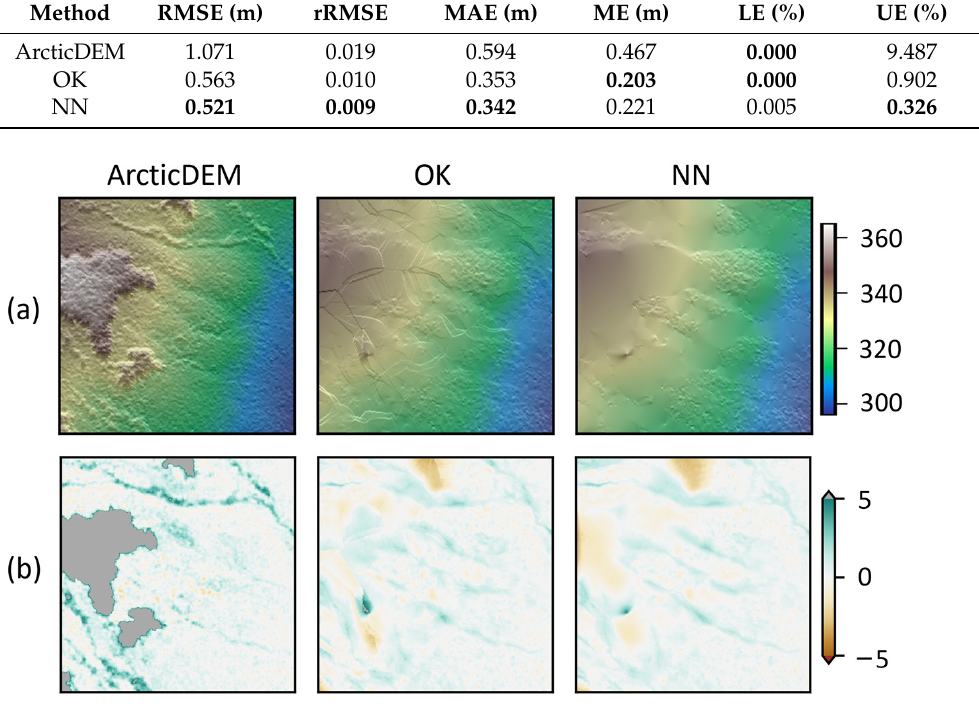
Table 5. Model evaluation metrics at Site-3. Areas outside the triangulation network were not evaluated for both ArcticDEM and the interpolated DTMs. Percentages of lower (LE) and upper (UE) extreme values were calculated in non-ground areas. Bold numbers indicate the best results.